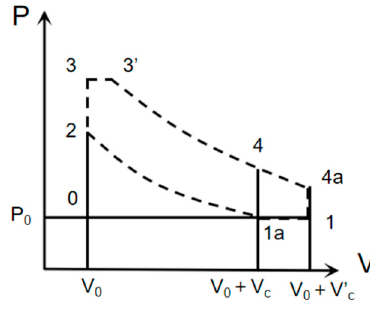
Figure 2. Miller cycle (LIVC) [5].